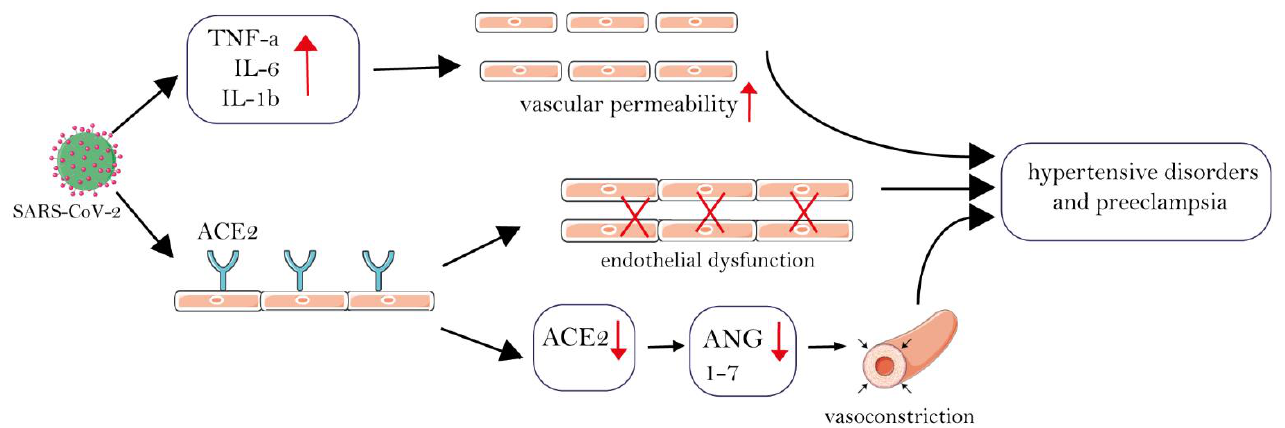
Figure 2. Association of SARS-CoV-2 with hypertensive disorders and pre-eclampsia. SARS-CoV-2 binds to ACE-2 and reduces ACE-2 and ANG-(1–7) levels. Reduced ANG-(1–7) decreases its vasodilatory effect and, therefore, enhances vasoconstriction. Endothelial cells also express ACE2 receptors and SARS-CoV-2 infection can cause immune cell-mediated endothelial damage, which is a hallmark of pre-eclampsia. Additionally, the virus invades the cells, activating the inflammatory response by increasing TNF-, IL-6, IL-1. This cytokine hyperproduction increases the risk of vascular hyperpermeability, which can lead to hypertensive diseases. These mechanisms could explain the hypertension problems seen in COVID-19 individuals who are pregnant. (ACE2= Angiotensin-converting enzyme 2, ANG = angiotensin, IL = interleukin, TNF-a = tumor necrosis factor α).